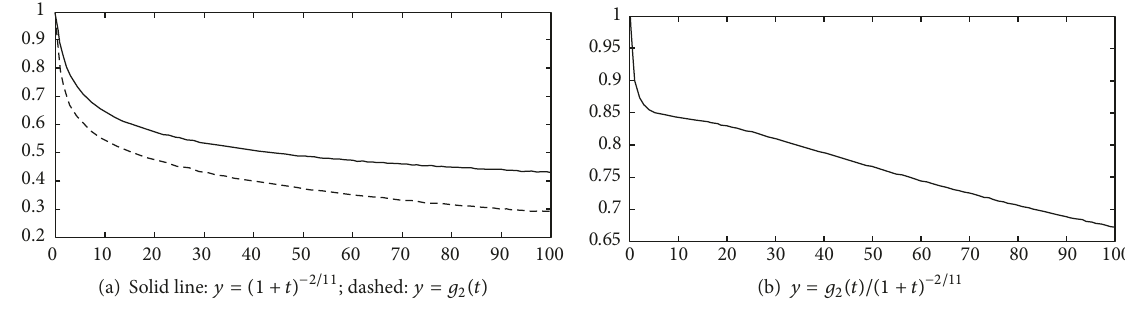
Figure 7: Polynomial